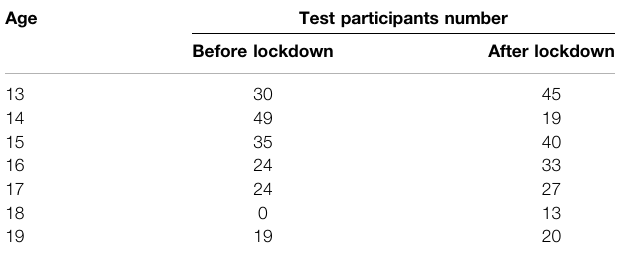
TABLE 1 | Age distribution of test participants. Age Test participants